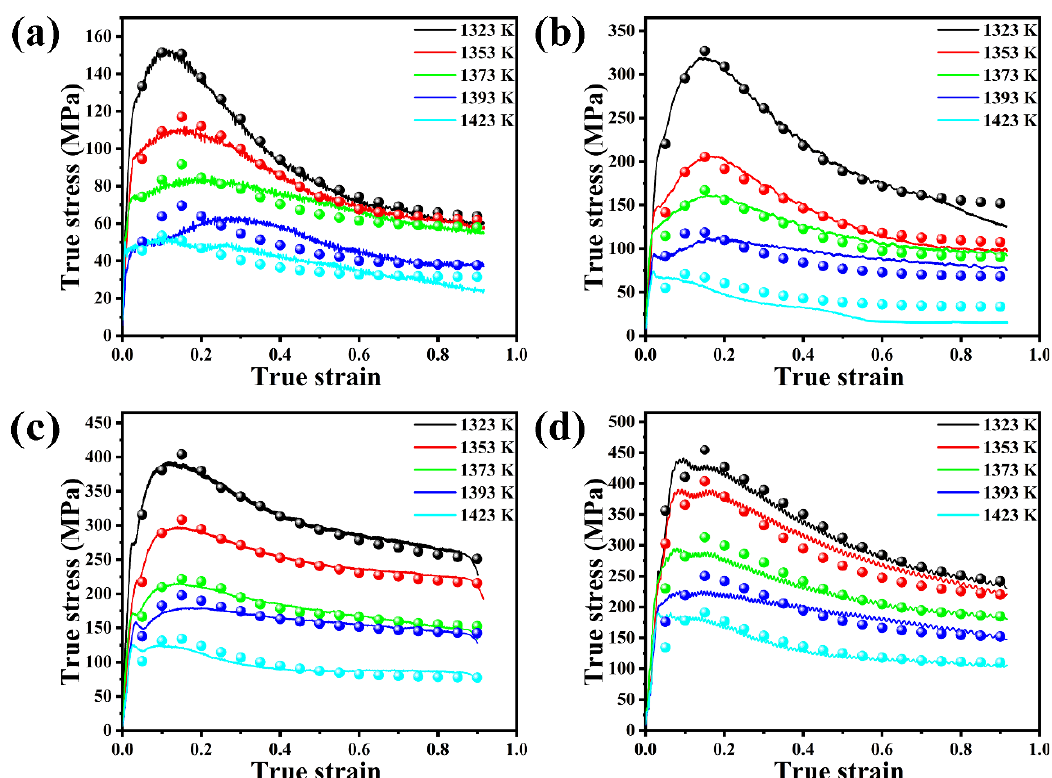
Figure 12. Comparison between the experimental (solid curves) and the predicted (symbols) stress– strain values with strain rates of ( a ) 0.01 s −1 , ( b ) 0.1 s −1 , ( c ) 1 s −1 , and ( d ) 5 s −1 . strain values with strain rates of ( a ) 0.01 s − 1 , ( b ) 0.1 s − 1 , ( c ) 1 s − 1 , and ( d ) 5 s − 1 .